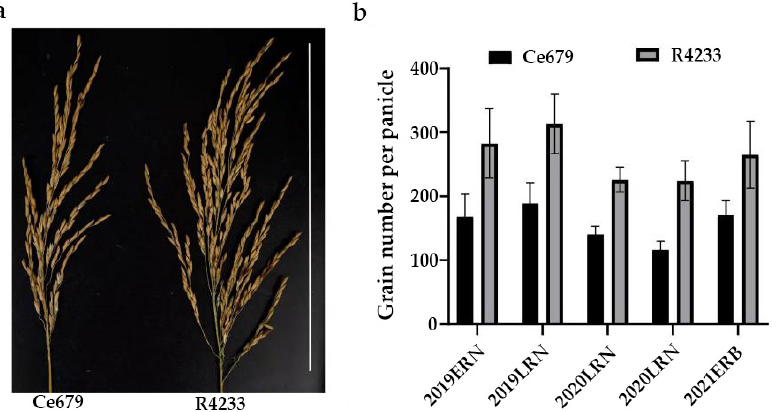
Figure 1. Analysis of the panicle structure between R4233 and Ce679. ( a ) Main panicle structure of Ce679 and R4233. The white line on the right side of the figure represents the scale bar in 25 cm length. ( b ) Histogram of the grain number per panicle in Ce679 and R4233. Data were collected over